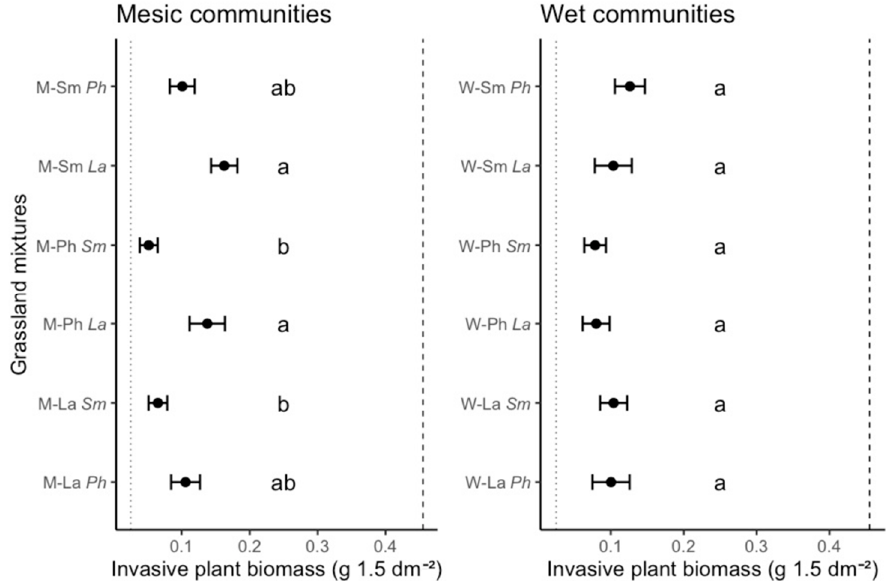
Figure 1. Grassland community effects on biomass of the native invasive Jacobaea aquatica (measured per tray area), in twelve trait-based grassland mixtures. Mesic (M) and wet communities (W), with standardized plant traits: Ph, plant height; La, leaf area; Sm, seed mass; first letters, constrained trait; and second letters , diversified trait. Vertical lines indicate as references the mean values of (i) a commercial grassland mixture (LfL, dotted line), and (ii) the J. aquatica monoculture (striped line). Significant differences were found among seed mixtures ( χ 2 = 39.3, df = 11, p < 0.001), but not between base communities ( χ 2 = 0.028, df = 1, p = 0.87, Table S3); different letters indicate results of pairwise post-hoc Tukey tests ( p < 0.05; mean ± SE; see Tables S5 and S6).